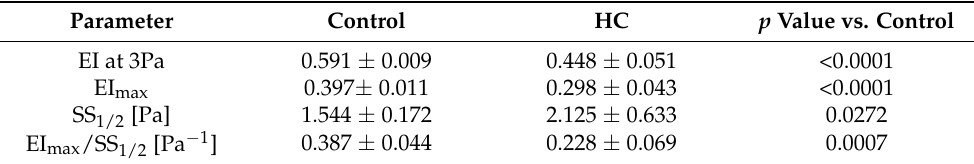
Table 2. The red blood cell deformability measurements in the Control and the atherogenic groups (HC). EI at 3 Pa: elongation index at shear stress of 3 Pa, EI max : the maximal elongation index, SS 1/2 : shear stress belonging to the half of EI max . Mean ± SEM.